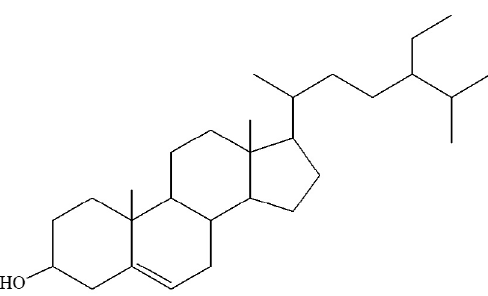
Fig. 8. The proposed structure of (3β, 24S)-stigmast-5- en-3-ol with synonym as